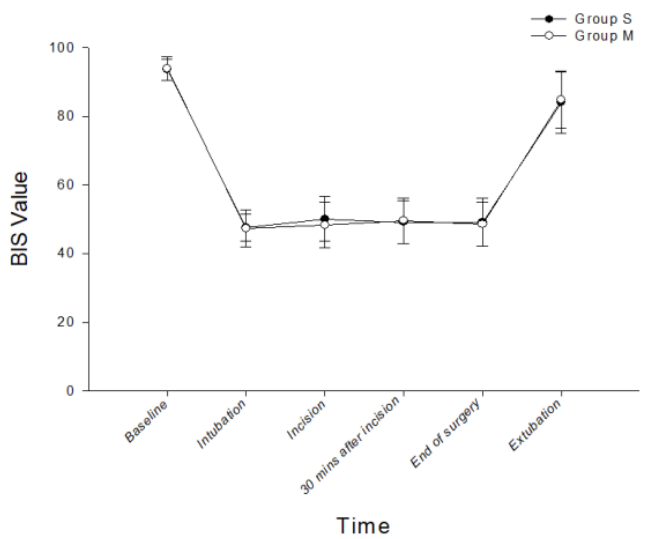
Figure 4. The BIS value for both groups at baseline and during anesthetic course. S group: propofol and remifentanil delivered by separate TCI pumps; M group: mixed propofol/remifentanil delivered by a single TCI pump; BIS: bispectral index.